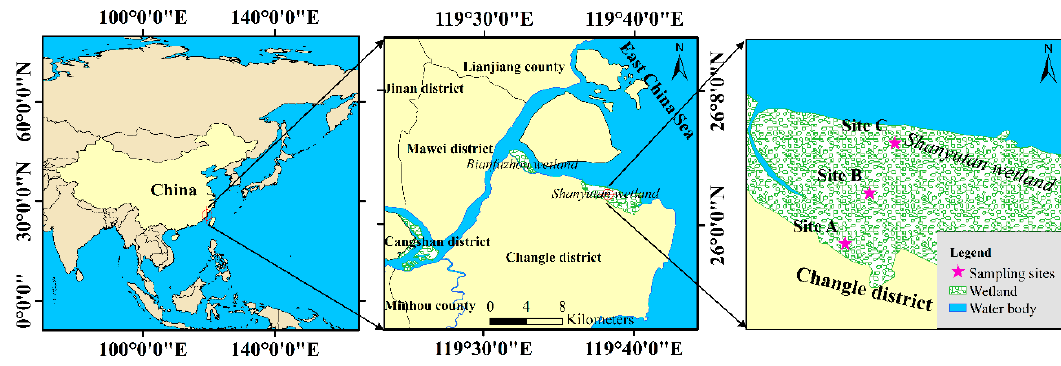
Figure 1. Study area and sampling sites.